Question: Which visualization type does this figure use?
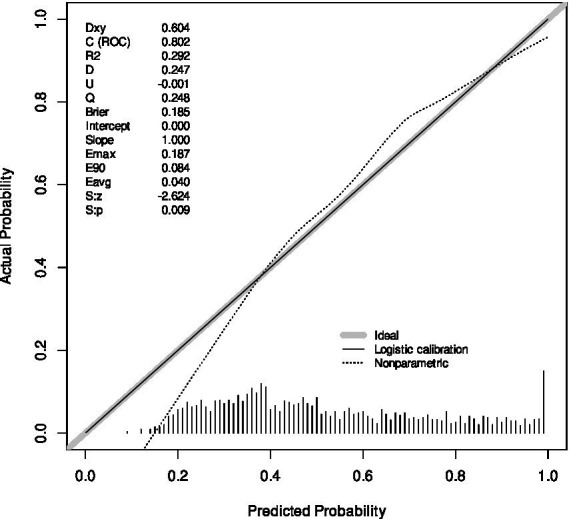
Answer: line